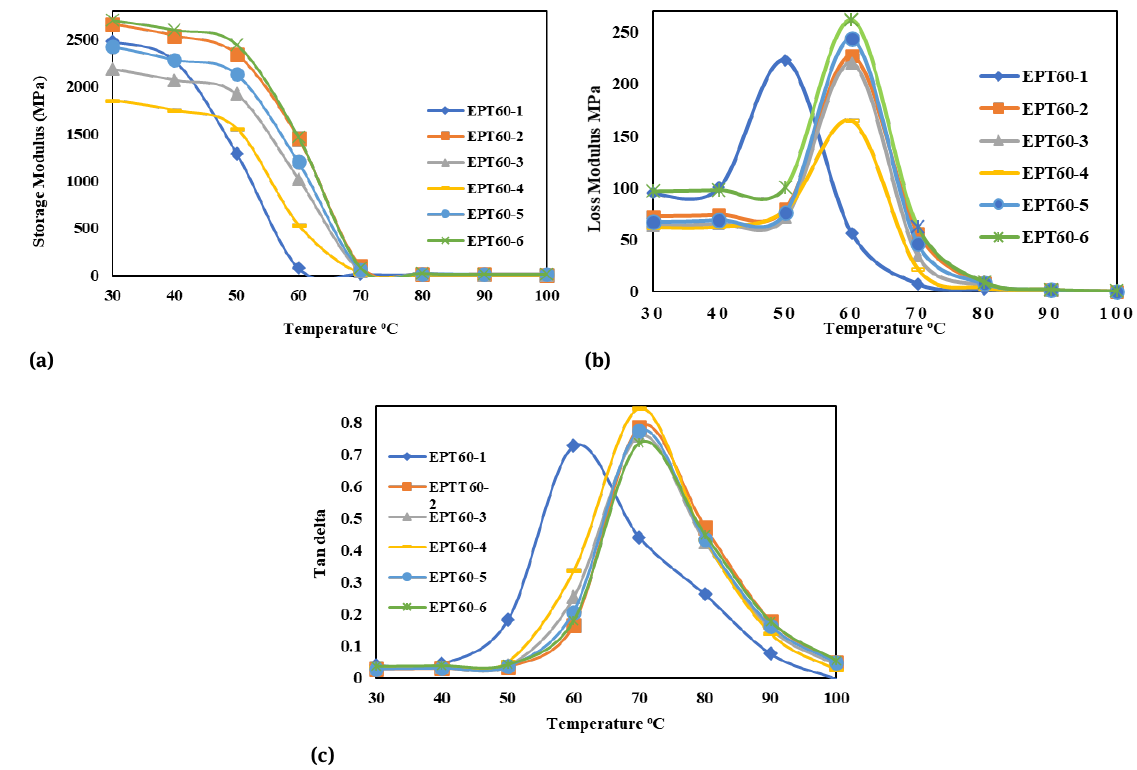
Figure 5: (a) Storage modulus, (b) loss modulus and (c) tan delta of HGMSF and neat epoxy matrix against temperature. Table 5: Comparison of storage modulus (SMD) and loss modulus (LMD) values of HGMSF composites and neat epoxy matrix resin.